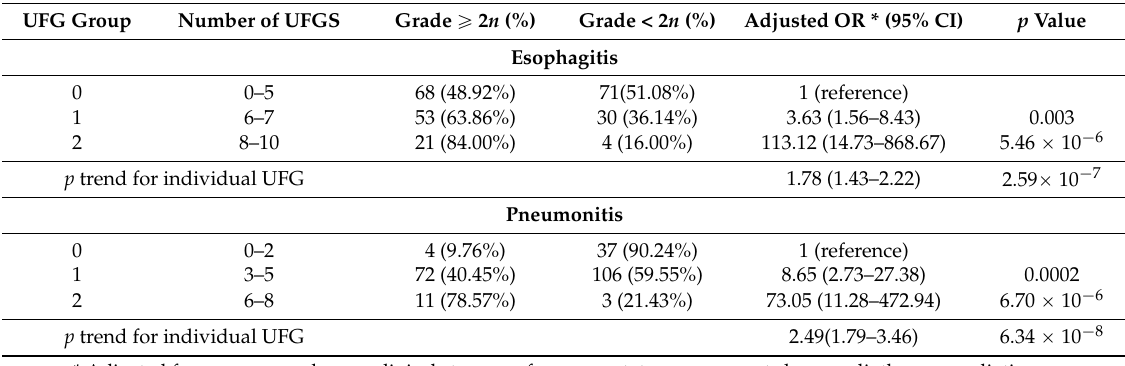
Table 4. Unfavorable genotype (UFG) analysis for radiation-induced